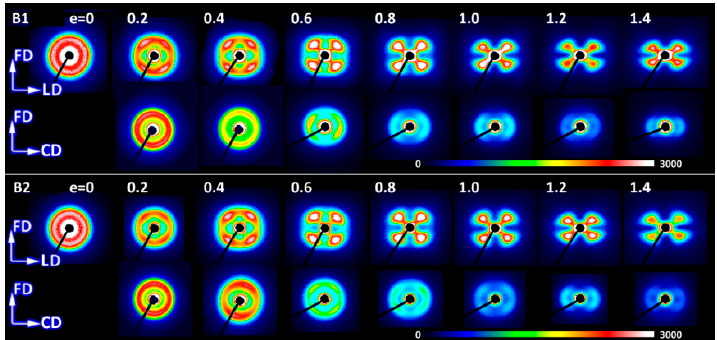
Figure 16. The 2-D SAXS patterns of samples of B1 and B2 homopolymers deformed to various strain (indicated) in the plane-strain compression. Patterns obtained in transmission with the primary beam along CD (first and third row) and along LD (second and fourth row). The flow direction (FD) is vertical.